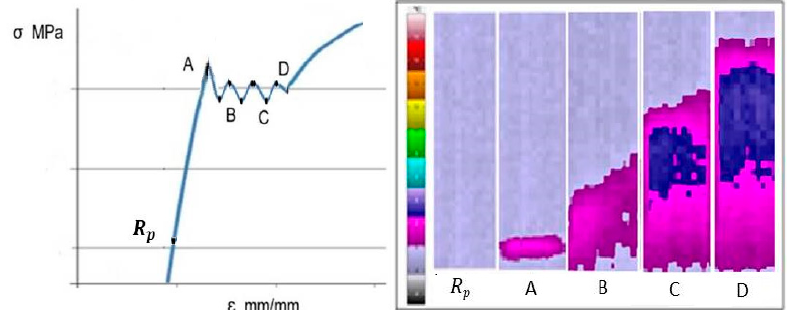
Figure 11. The stress–strain curve and distribution of temperature change at the beginning of the plastic material flow in the field of the appearance of Lüders bands.